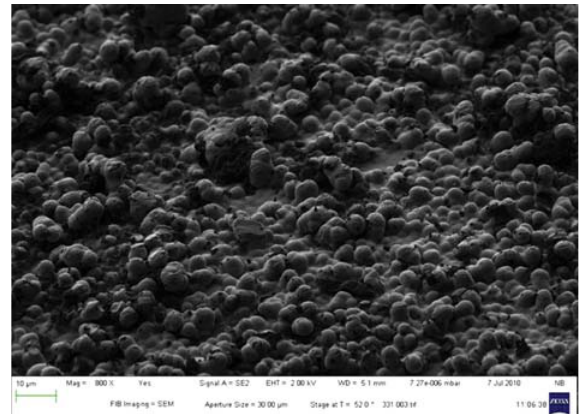
Figure 16: Spherical structured surface (lifetime: 400,000 cycles).